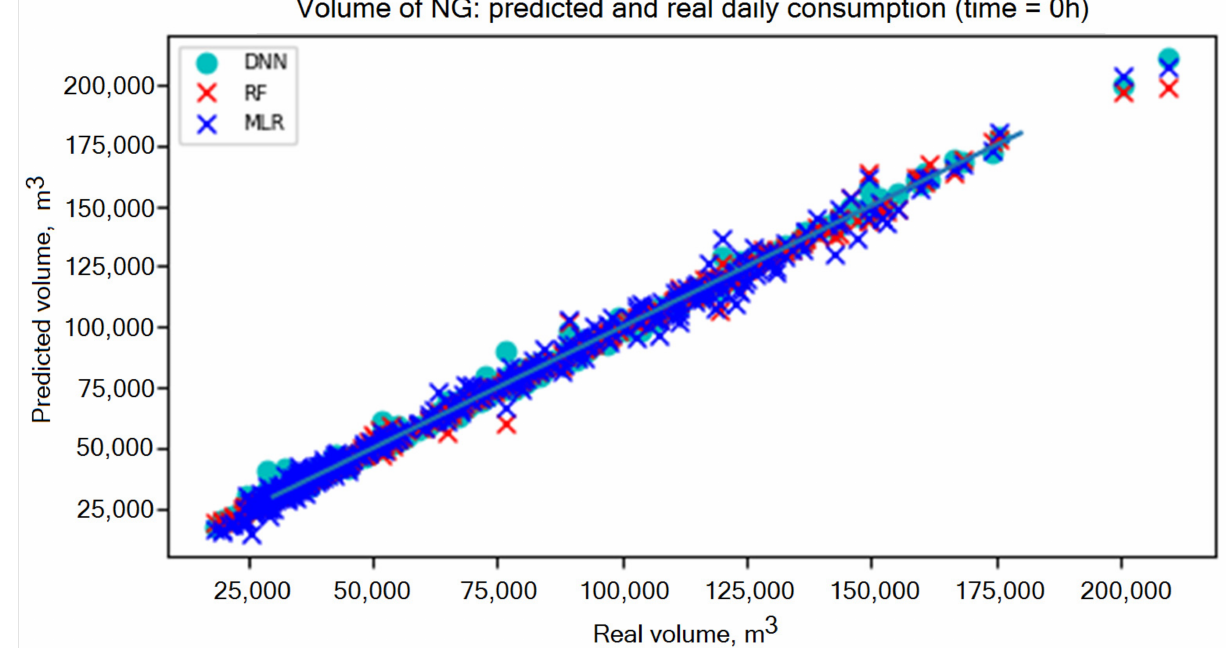
Figure 8. Actual and predicted natural consumption for metering station (Time +0